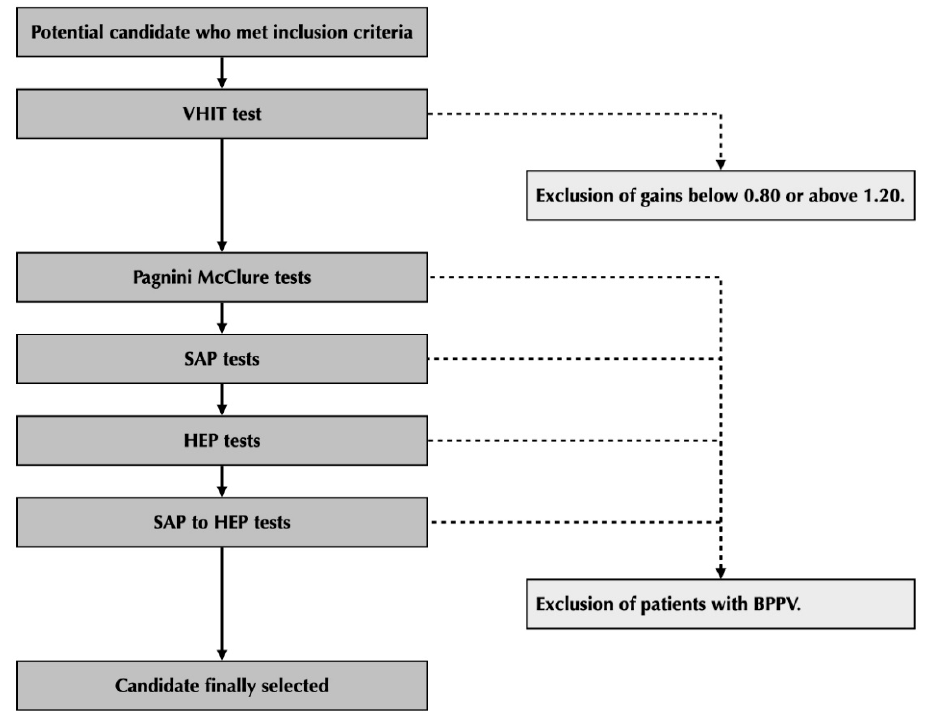
Figure 2. Flowchart of our protocol. The different inclusion and exclusion steps and the performed tests are summarized.